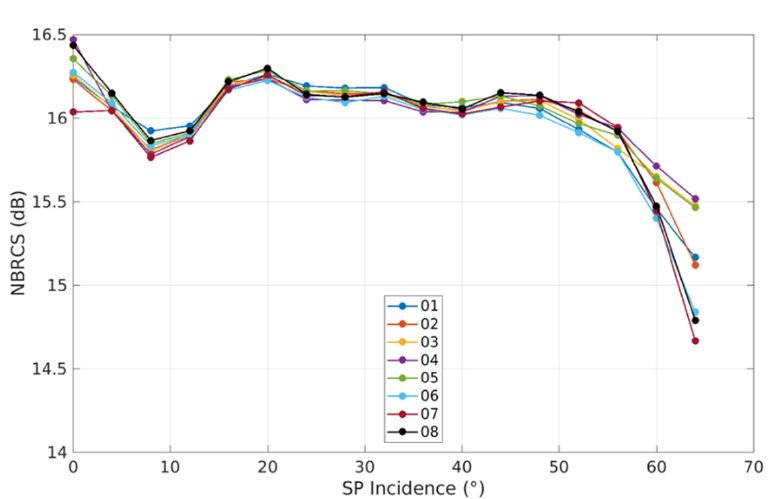
Figure 4. Dependence of NBRCS on incidence angle (from nadir 0° to 65°) at U10 ~7m/s, averaged for all GPS transmitters/SVNs; each line (and colour) represents a different CyGNSS Flight Model/receiver (FM01-FM08).